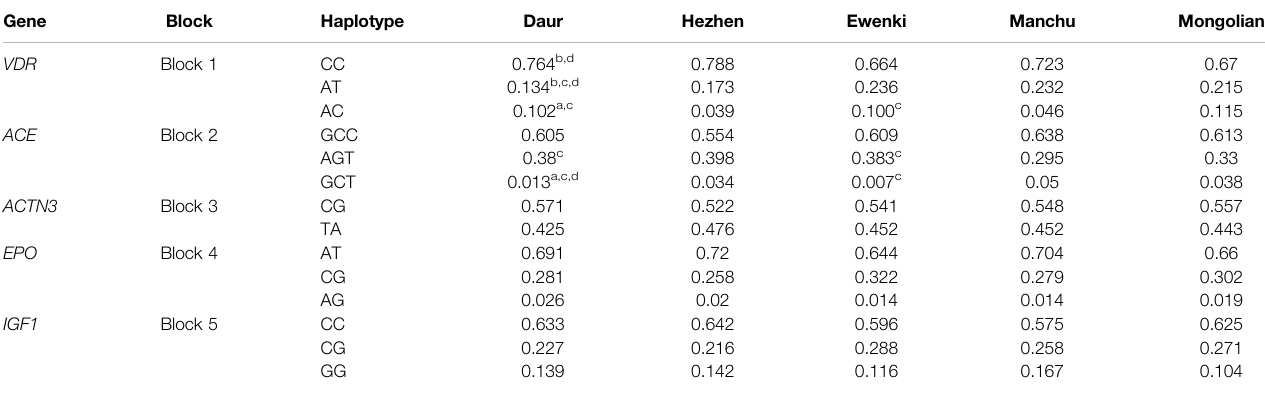
TABLE 6 | Haplotype frequencies in fi ve ethnic populations. Gene